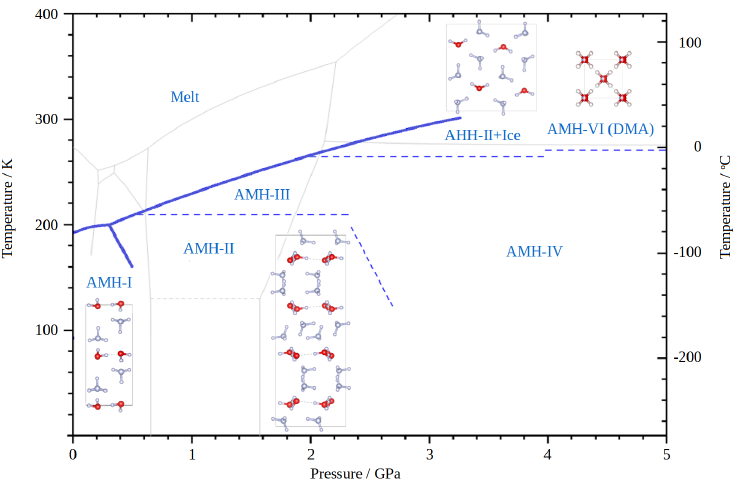
Figure 1. The AMH phases diagram. For the known crystal structures, the respective unit cells are shown. Please note that broken lines do not denominate phase boundaries, but rather a line at which the respective other phase first appears. The grey lines in the background give the phase diagram of water as a reference. The melting curves and phase boundaries are taken from